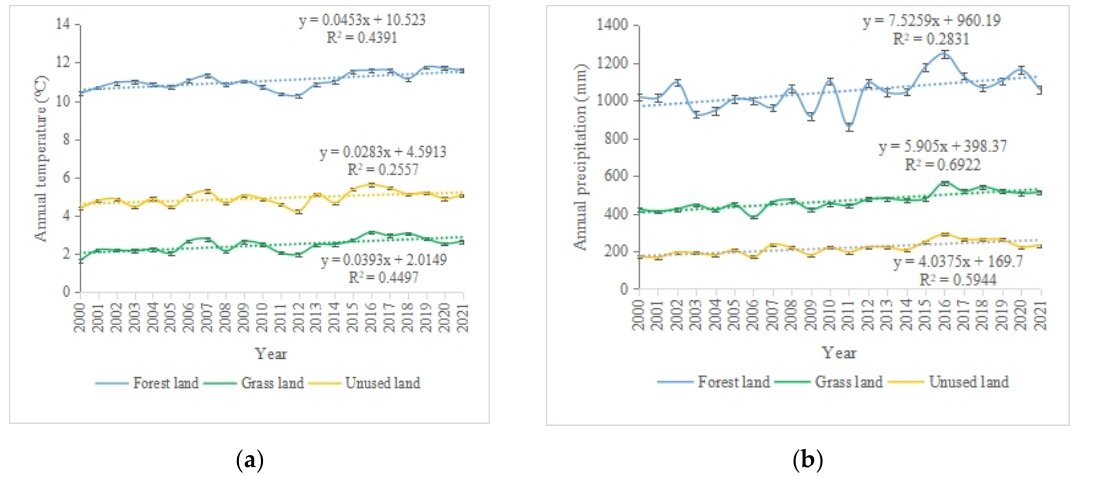
Figure 4. Rising air temperature ( a ) and annual precipitation ( b ) in forest land, grass land, and unused land from the average value of 1 km × 1 km grid cells during the period 2000–2021.